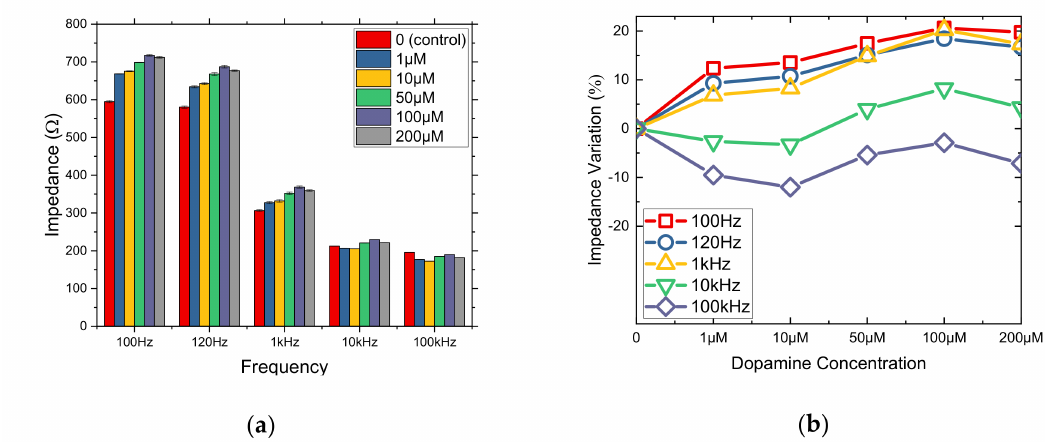
Figure 5. Mean impedance values ( a ) and % impedance variation ( b ) for cells immobilized in PLL matrix treated with µ M DA concentrations (1, 10, 50, 100, 200 µ M) at five different